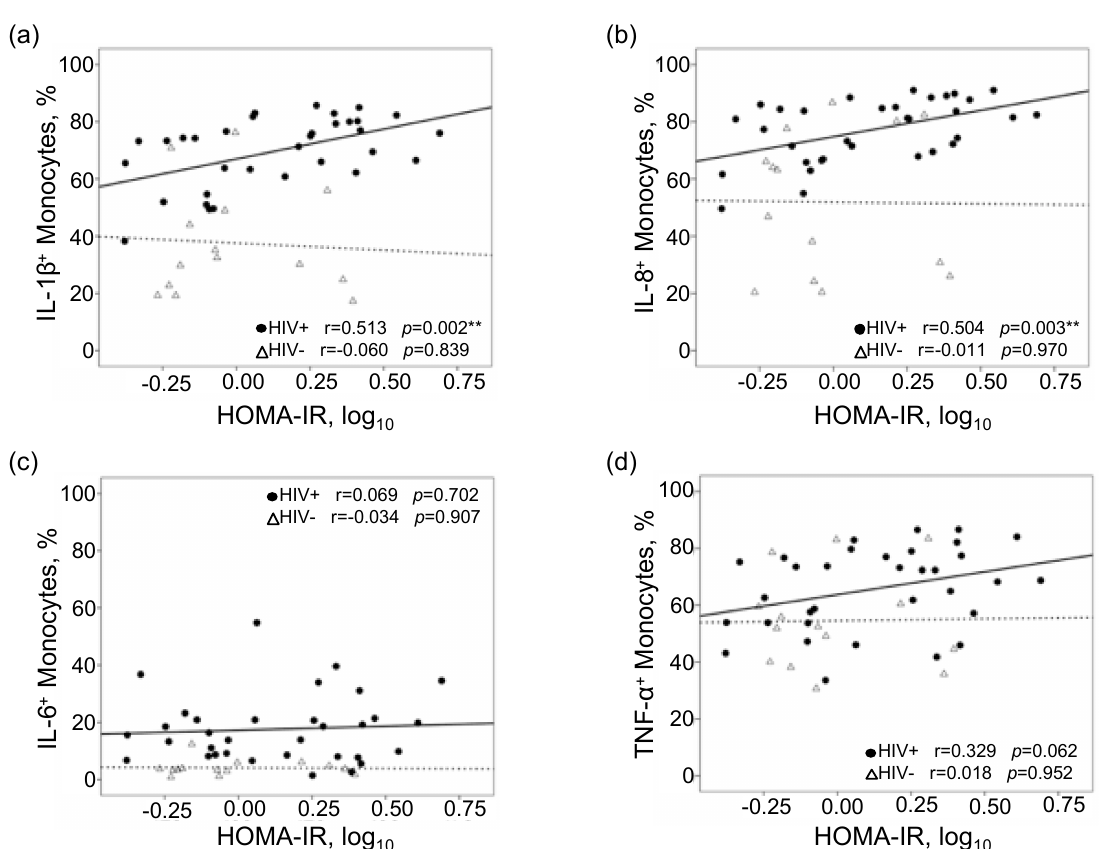
Figure 1. Scatterplots and Pearson correlations of frequencies of intracellular cytokine-producing monocytes to homeostatic model assessment-insulin resistance (HOMA-IR). Correlation plots of frequencies of ( a ) IL-1 β + , ( b ) IL-8 + , ( c ) IL-6 + , and ( d ) TNF- α + monocytes (oxidized LDL stimulated) to HOMA-IR. Solid line represents best fit line for PLWHA ( n = 33) and dashed line represents best fit line for controls ( n = 14). * p < 0.05, ** p < 0.01.